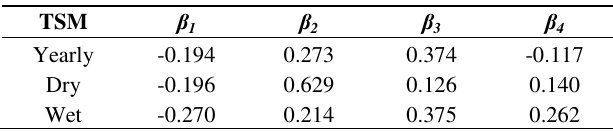
Table 5. Standardized regression coefficient values for TSM models.